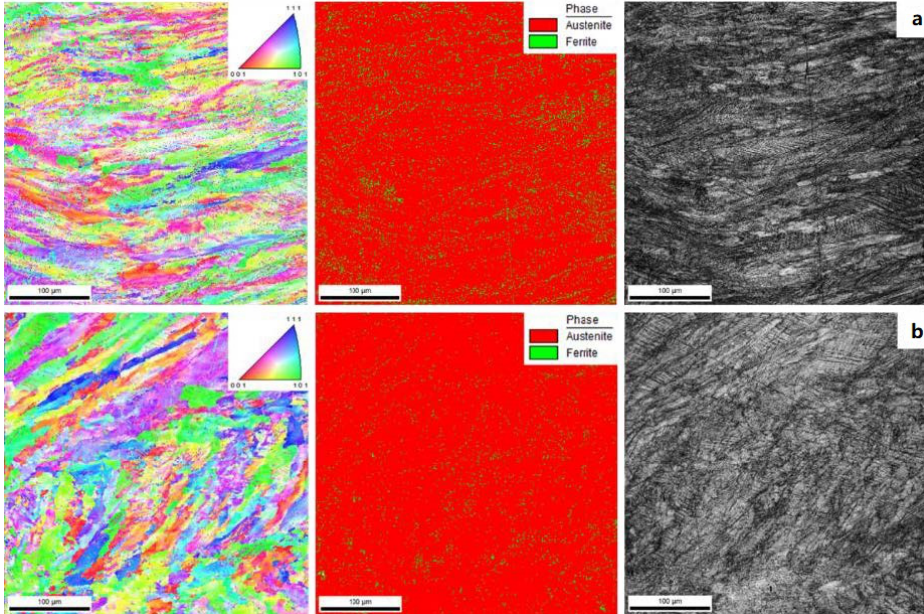
Figure 15. EBSD Orientation Imaging Microscopies (OIM) and phase mapping: ( a ) 𝑇 11 ; ( b ) 𝑇 31 after conducting the tensile test.